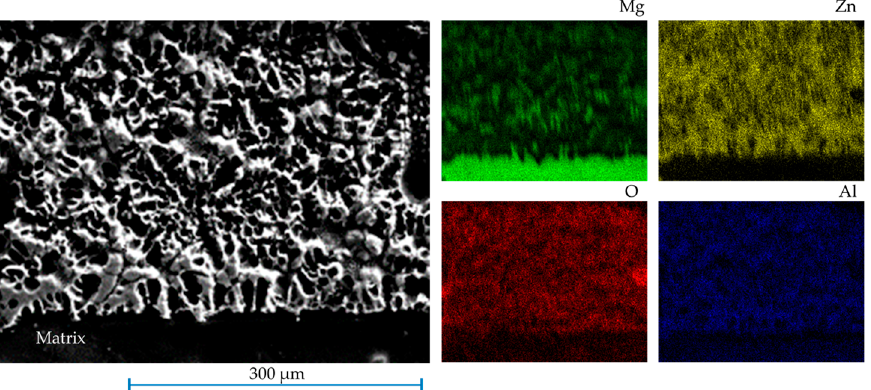
Figure 5. Morphology of a cross-section of the intermetallic layer on an as-surface-alloyed AZ91D magnesium alloy specimen obtained with zinc oxide as the Zn donor and the corresponding Mg, Zn, O, Al element maps.